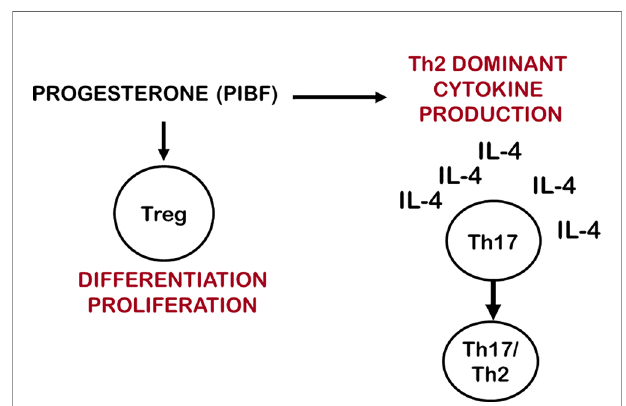
FIGURE 2 | Progesterone affects IL-17 cell differentiation and Treg cell function. By inducing Th2 dominant cytokine production, progesterone creates and IL-4 rich environment, which enables Th17 cells to differentiate to Th17/Th2 cells. Via membrane-or nuclear progesterone receptors progesterone stimulates the differentiation and proliferation of clonally expanded Treg